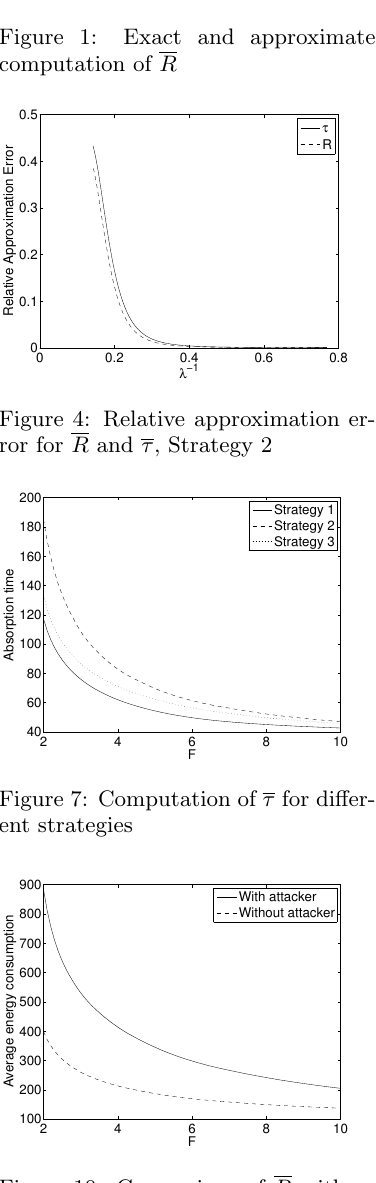
Figure 12: Ratio between values of R with and without attacker, F ∈ [2 ,